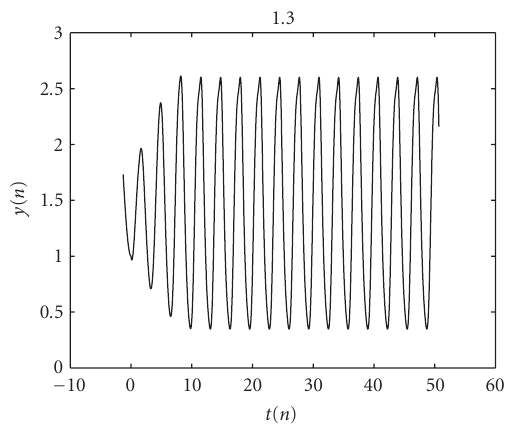
Figure 4.3. System exists on attracting invariant closed curve for τ = 1 . 3 > 1 .